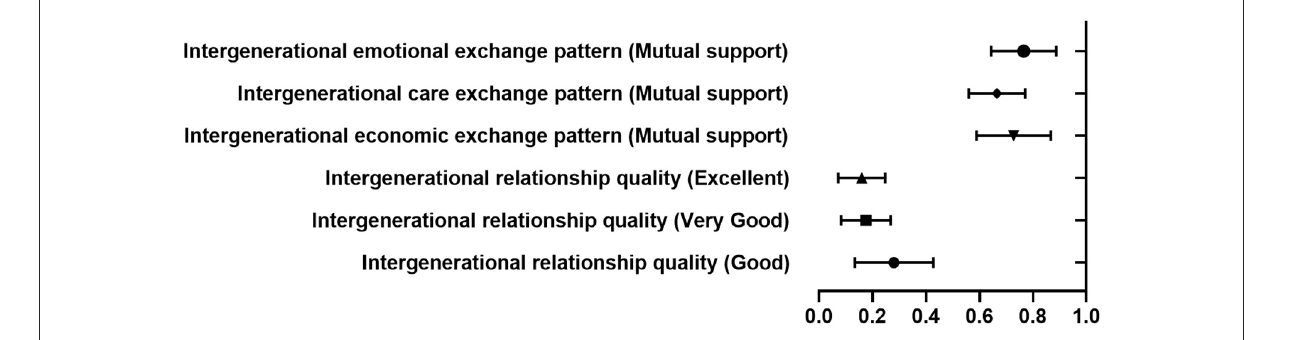
FIGURE1 Forest diagram of factors influencing depressive symptoms in the